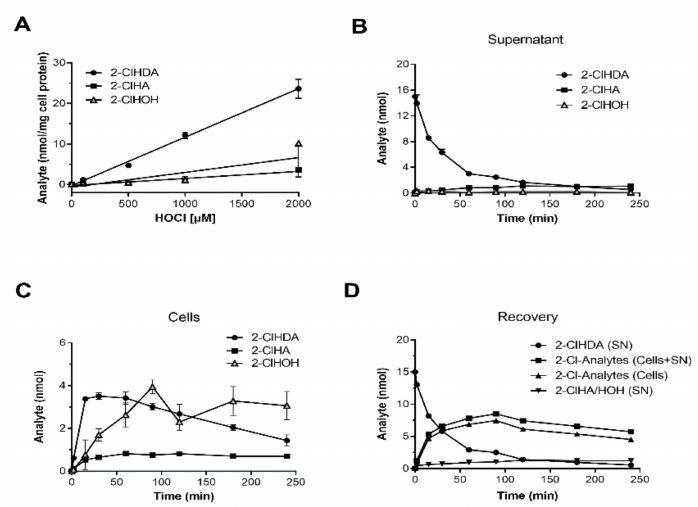
Figure 3. In vitro formation and metabolism of 2-ClHDA in the murine HL-1 cardiomyocyte cell line. HL-1 cells were incubated with increasing concentrations of NaOCl or 2-ClHDA (15 µ M). ( A ) After treatment with indicated concentrations of NaOCl for 1 h, cells were extracted in the presence of the corresponding internal standard as outlined in Materials and Methods. After conversion to their corresponding PFB-derivatives, 2-ClHDA, 2-ClHA, and 2-ClHOH concentrations were quantitated by NICI-GC–MS analysis. Results are displayed as mean ± SD ( n = 3). ( B , C ) Cells were incubated with 15 µ M 2-ClHDA for up to 4 h. At the indicated time points, 2-ClHDA, 2-ClHA, and 2-ClHOH concentrations were analyzed by NICI-GC–MS analysis in ( B ) the cellular supernatants and ( C ) HL-1 cells. Data represent mean ± SD values ( n = 3). ( D ) Time-dependent recovery of 2-Cl-metabolites in HL-1 cells. Data represent loss of 2-ClHDA from the supernatant (SN), recovery of 2-Cl-Analytes (sum of 2-ClHDA, 2-ClHA, and 2-ClHOH in the SN or cells), and recovery of 2-ClHA plus 2-ClHOH in the supernatant (for reasons of clarity only mean values are